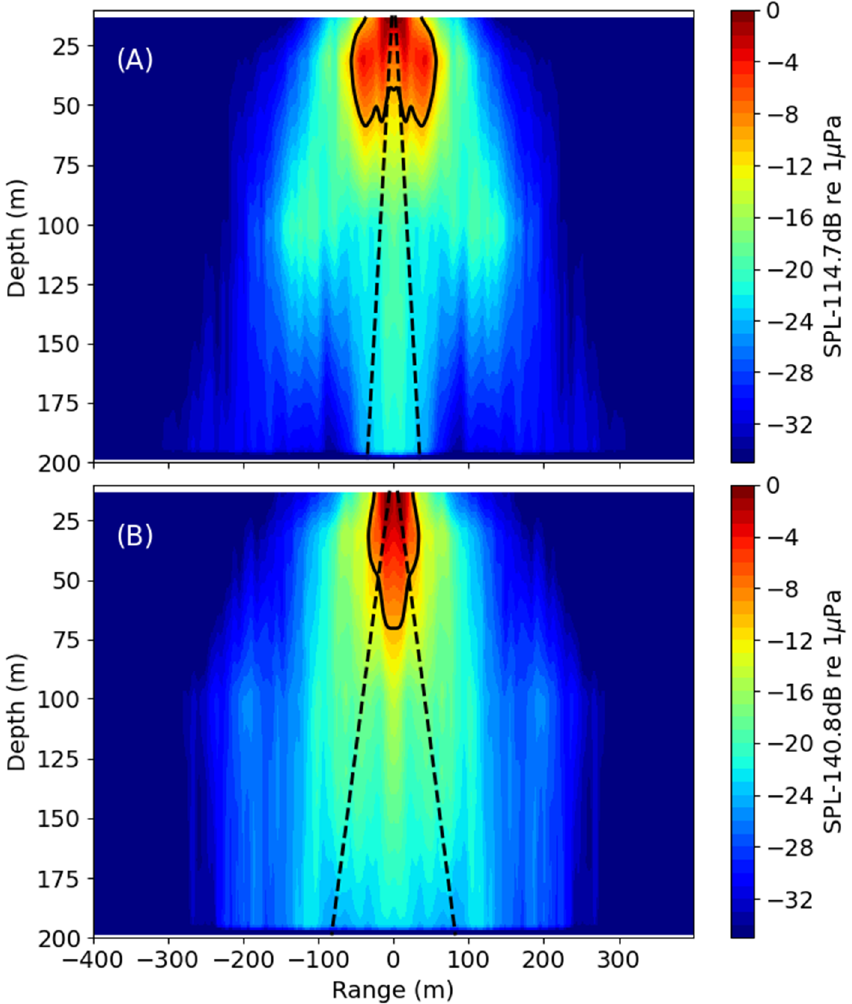
Figure 7. Received sound pressure levels (SPLs) showing the echosounder signal’s extent over vertical and horizontal space from the nominal ( A ) 200 kHz (198–206 kHz) and ( B ) 83 kHz (80–87 kHz) signals in deep water. The dashed black lines indicate the 20° and 45° beam widths for the 200 and 83 kHz channels, respectively. The solid black lines indicate −10 dB from below the maximum measured SPL (maxSPL) (114.7 dB re 1 µPa m for 200 kHz and 140.8 dB re 1 µPa m for 83 kHz) contour, and the dashed lines indicate the −40 dB contour. Please note that the data shown are symmetrical for negative and positive ranges for clarity.